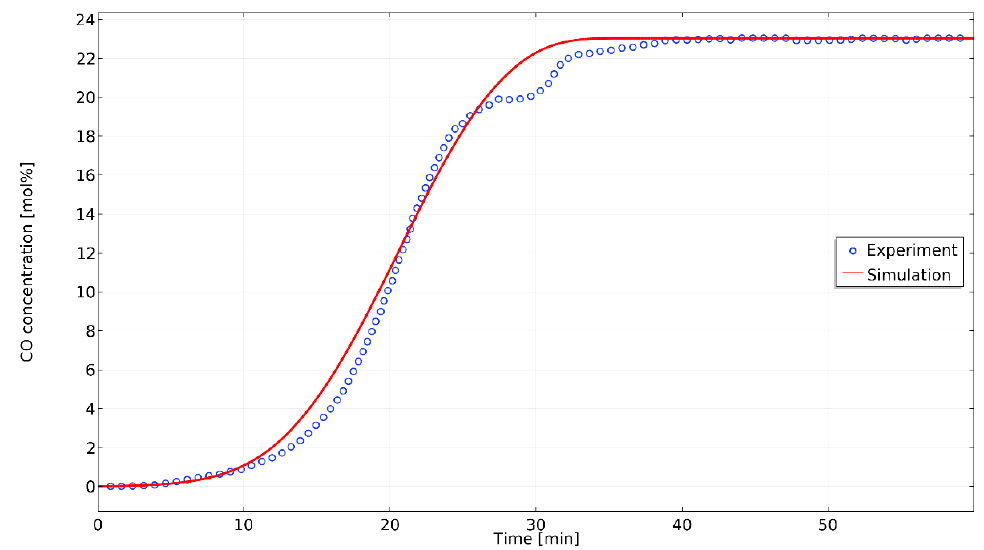
Figure 8. Experimental (blue circles) and model predicted (red line) CO breakthrough